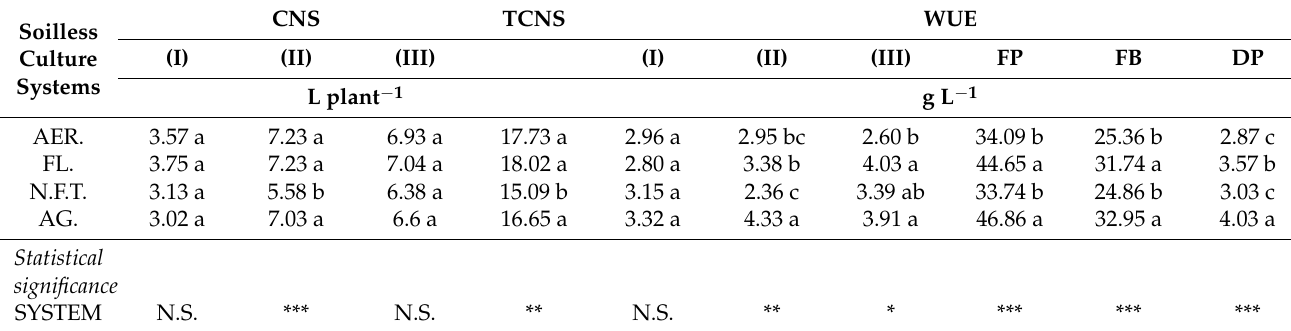
Table 6. Impact of the CSCS on: (A) the consumption of nutrient solution (CNS—L plant − 1 ) and on the total consumption of nutrient solution (TCNS—L plant − 1 ), B) the water use efficiency (WUE) expressed as the dry weight produced (g) per L of nutrient solution consumed (WUE—g L − 1 ) during the 3 samplings (I, II, III), i.e., 31, 62, and 95 DAT and as the fresh weight of the plant (FP), the bulb (FB) and the dry weight of the plant (DP), (g L − 1 ) at harvest divided by the